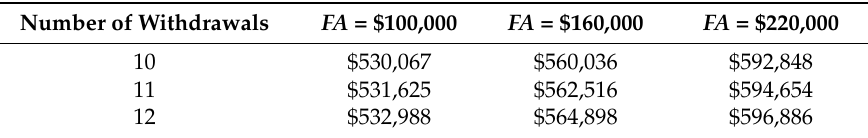
Table 4. Selected values of legacy potential for the case study.